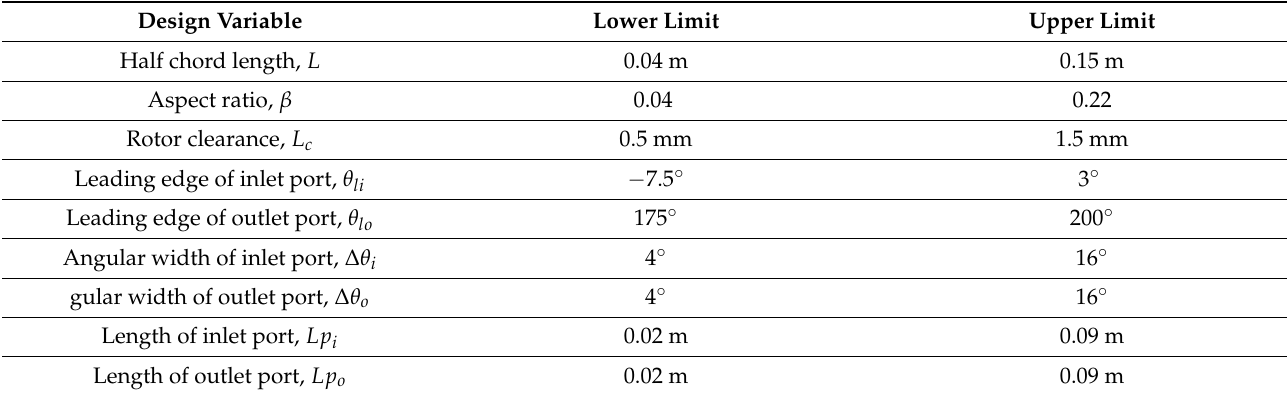
Table 3. The searching domain of each design